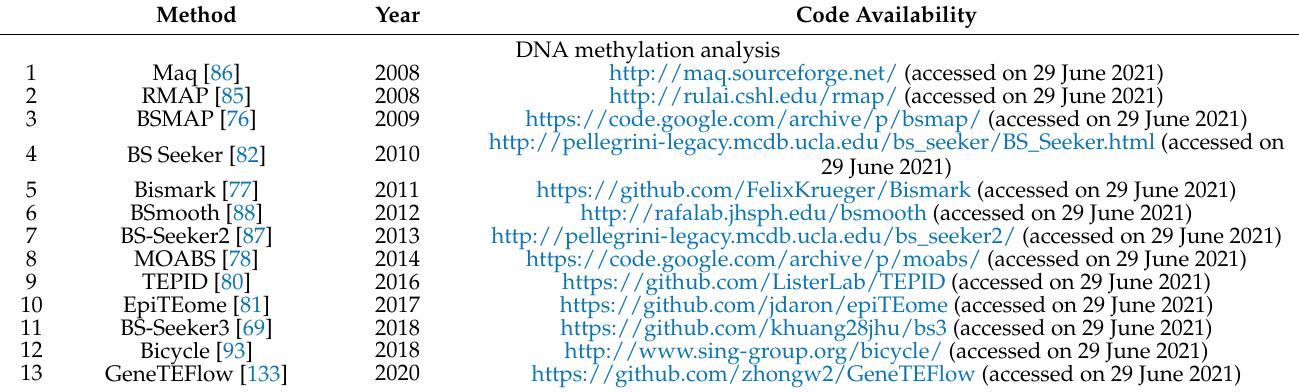
Table 10. Bioinformatics and ML tools for exploring the regulation of TEs and the repository for the relevant data/code.